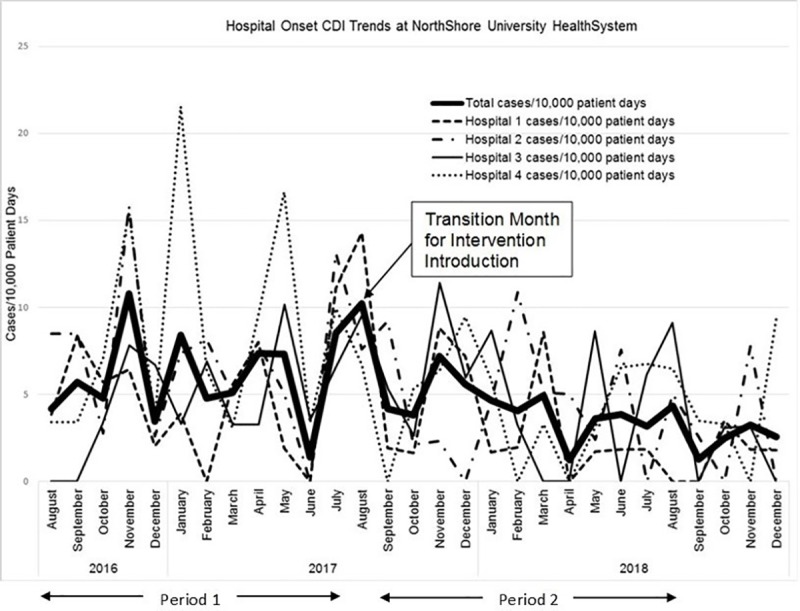
Monthly incidence of HO-CDI during 29 months of observation (S1 Table).